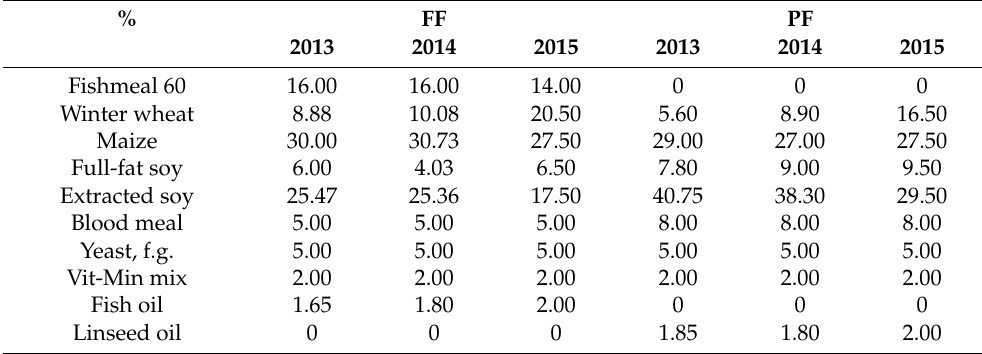
Table 1. Ingredients (in percentage) of the artificial feeds (FF: feed with fish meal, PF: plant-based feed) used in the experiment, cereal feed (CF) consisted of winter wheat only.